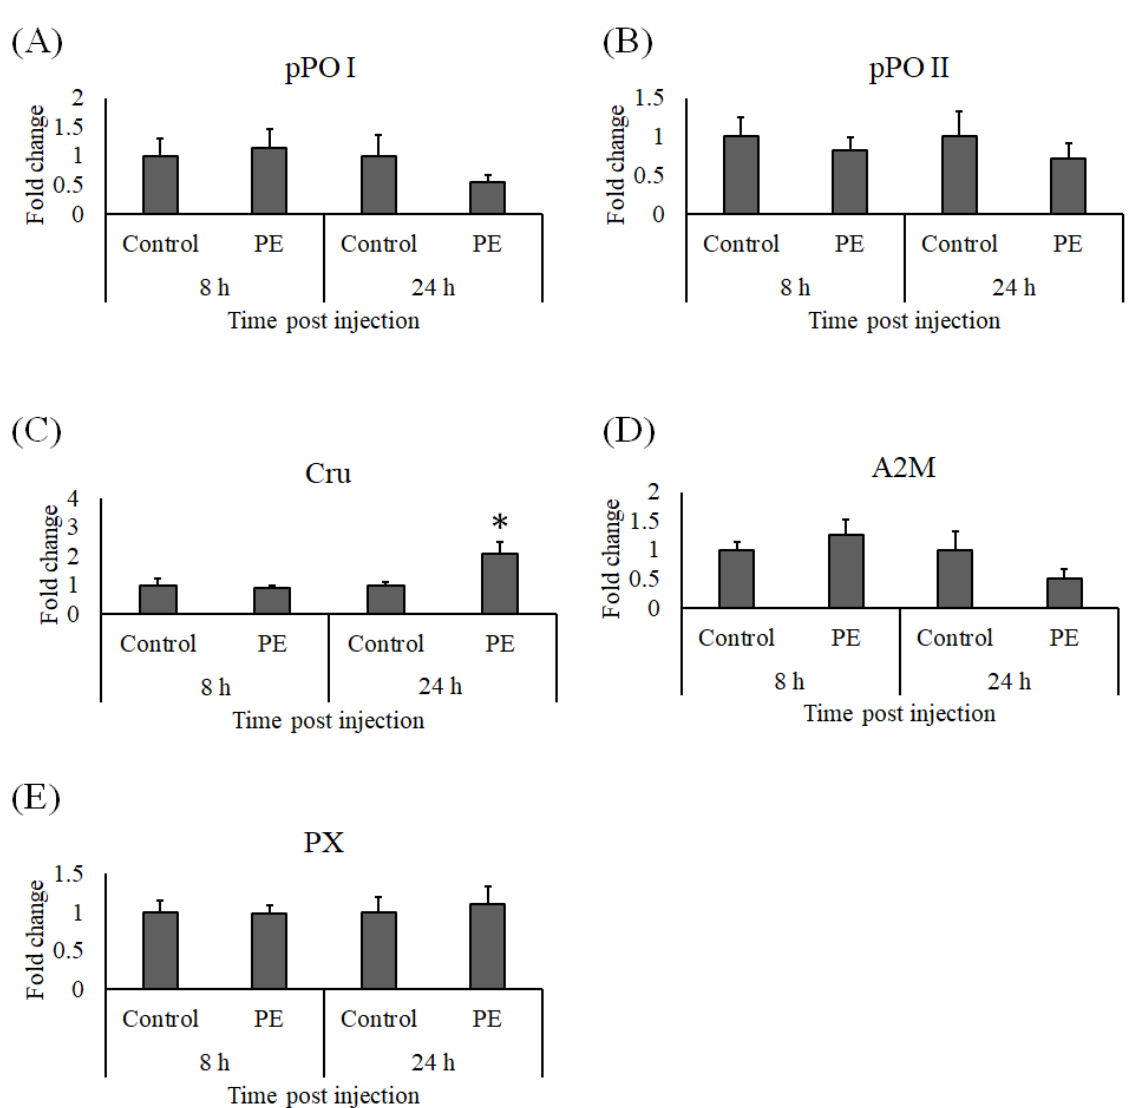
Figure 7. Gene expression of ( A ) proPO I , ( B ) proPO II , ( C ) Cru , ( D ) A2M , and ( E ) PX in hemocytes from whiteleg shrimp ( Litopenaeus vannamei ) injected with 0.30 μ g of phycoerythrin (PE) per gram of whiteleg shrimp body weight or vehicle alone (control). After 8 and 24 h of stimulation, the relative expression levels of immune genes were normalized to the transcript level of EF1 α and presented as a fold change relative to the control group. Data are shown as the mean ± standard error of the mean ( n = 5) and significant differences from the control group are denoted by asterisks ( p < 0.05 , paired sample t -test).